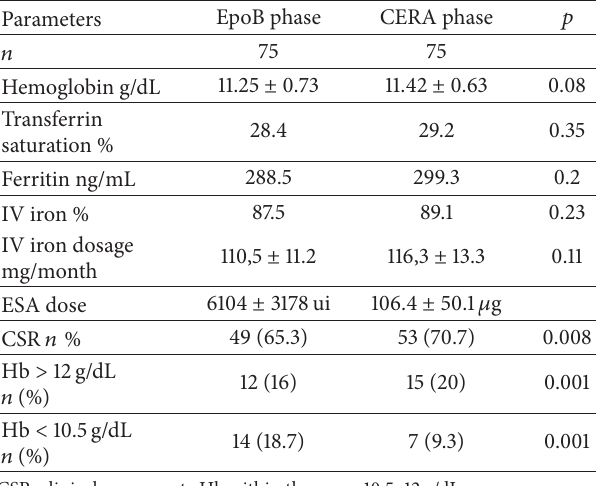
Table 2: Anaemia management during the